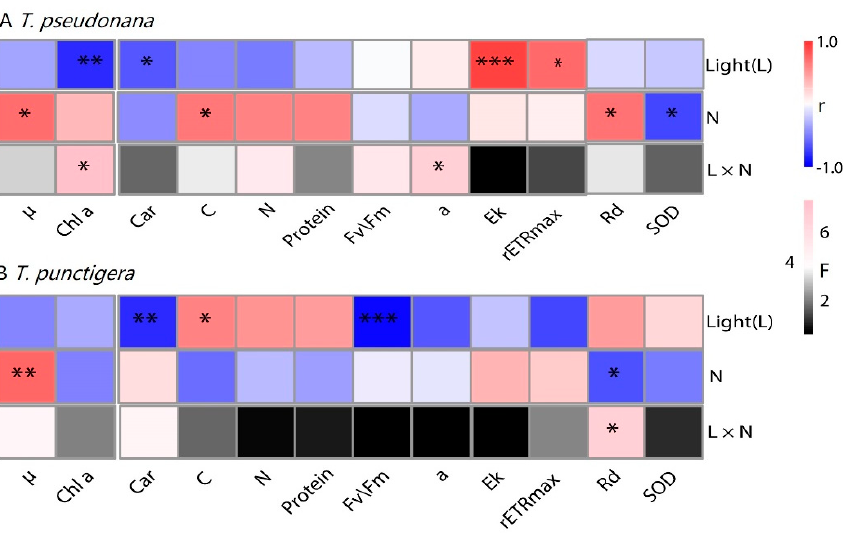
Figure 7. Effects of upward-shifted light and N on biochemical and physiological parameters, with the color gradient denoting the r values of Pearson’s rank correlation coefficients and the F values of the interaction of light and N. (*: p < 0.05, **: 0.01 < p < 0.05, ***: p < 0.01).